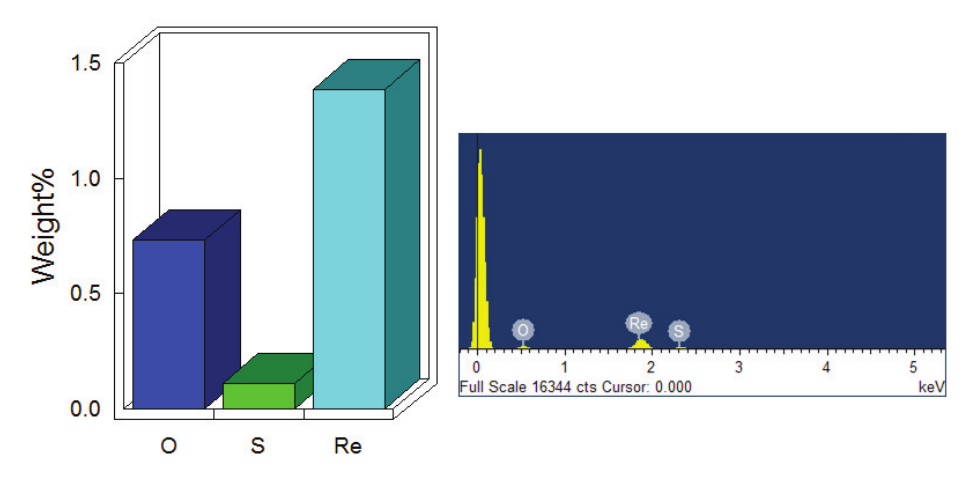
Figure 3: SEM-EDX analysis of the purest distillation